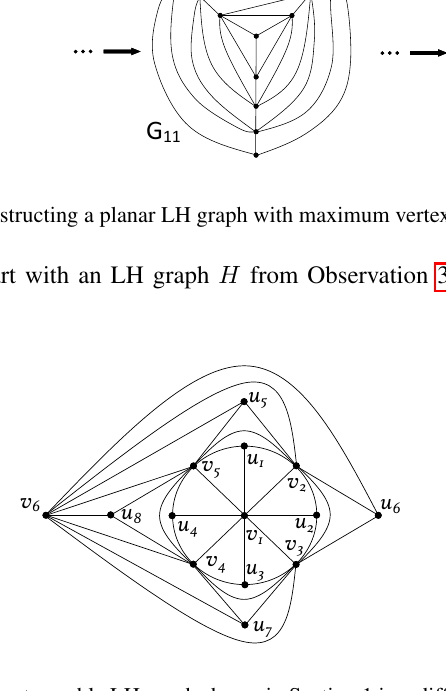
Fig. 13: The order 14 nontraceable LH graph shown in Section 1 in a different